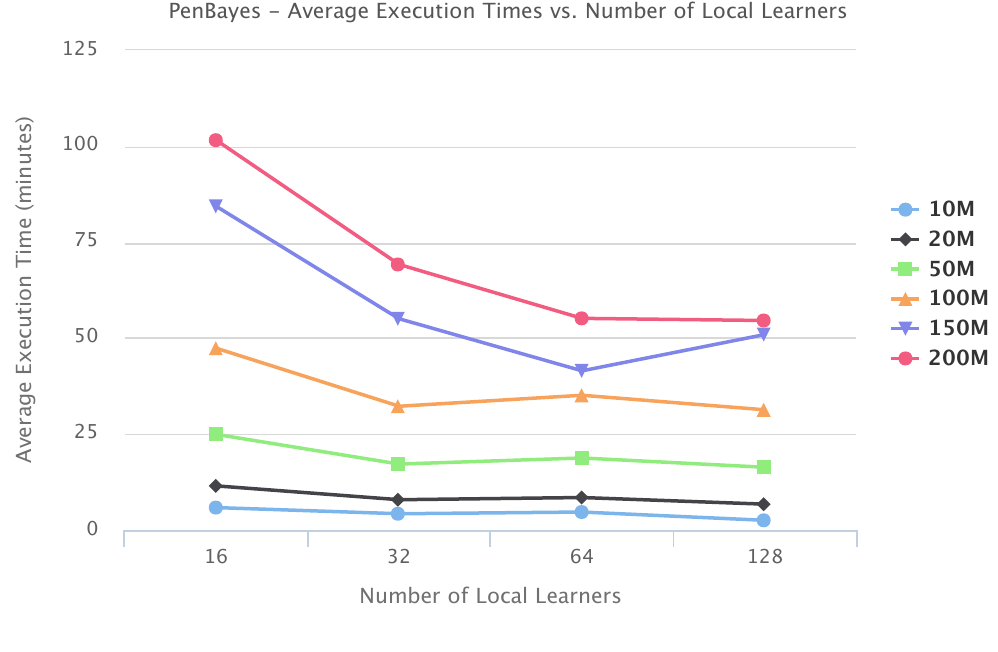
Figure 17. Alarm Set Execution Time vs. Number of Local Learners.